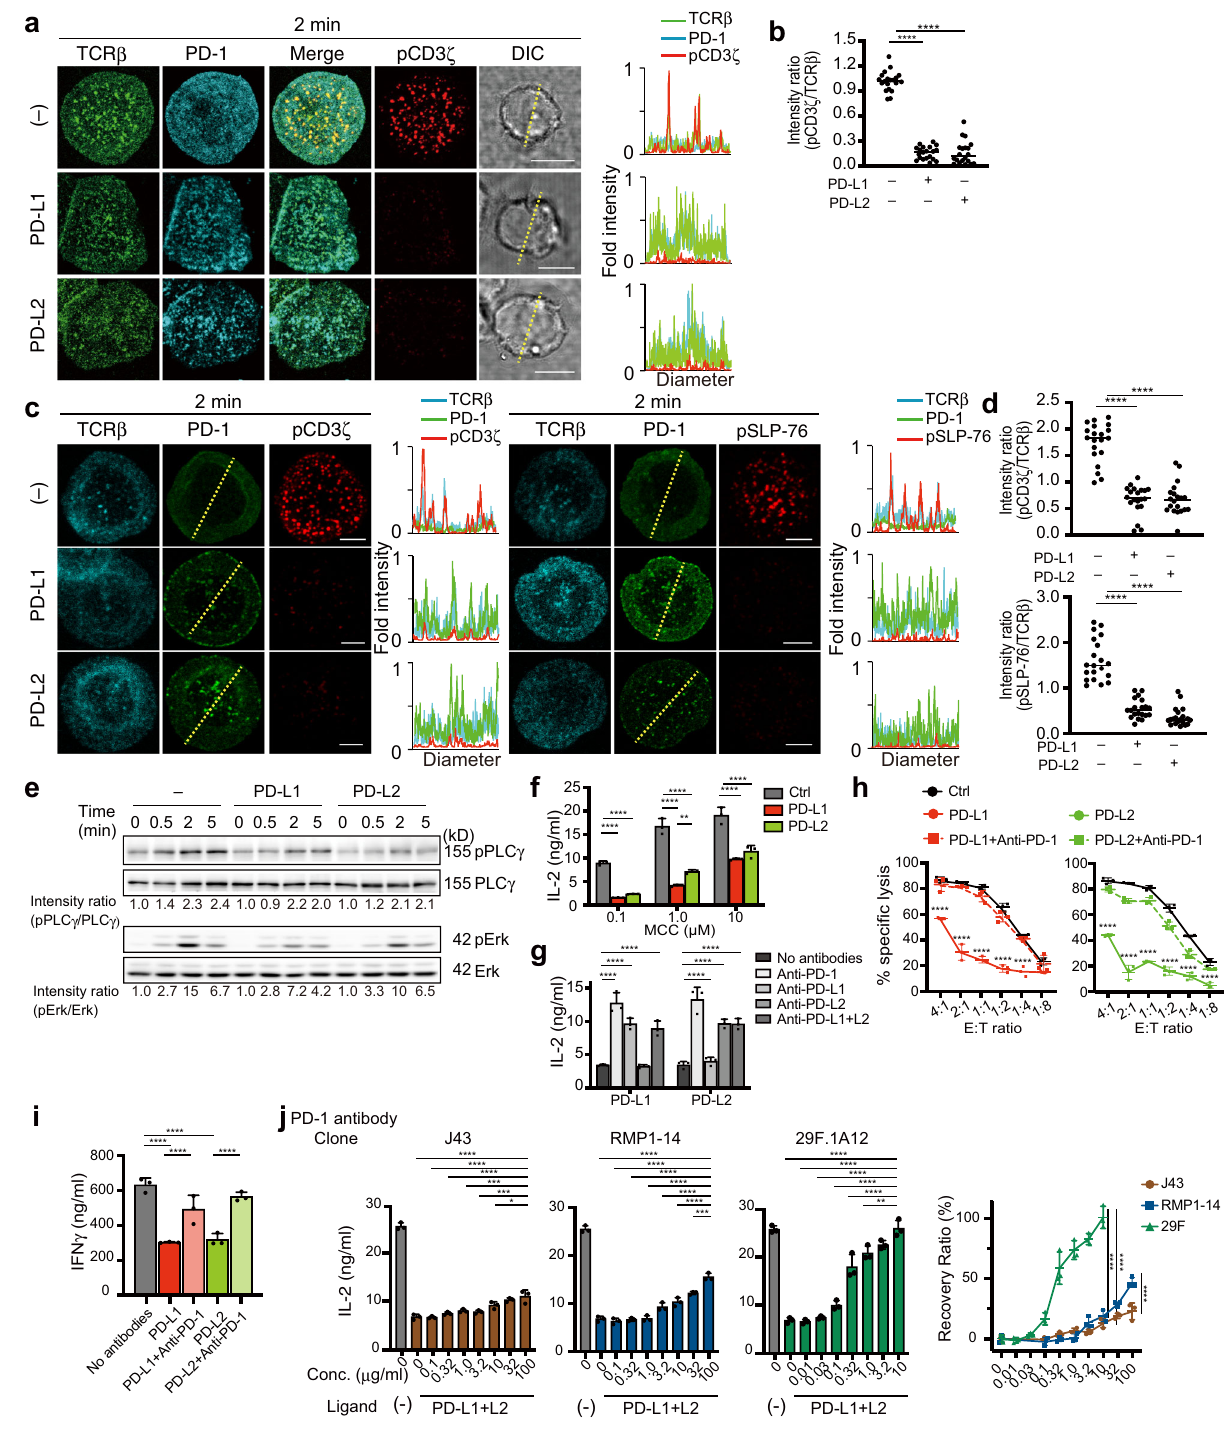
4 : 1 2 : 1 1 : 1 1 : 2 1 : 4 1 : E:T ratio